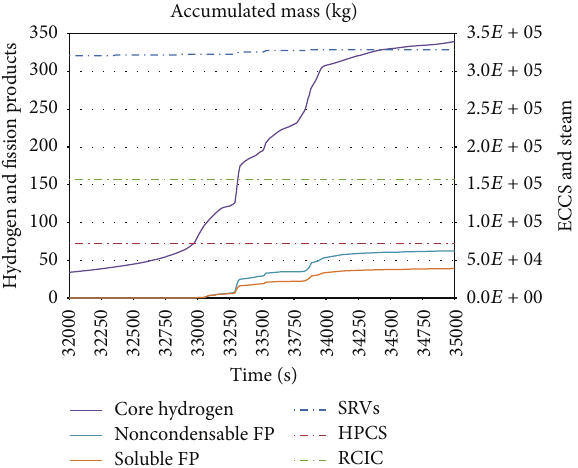
Figure 15: Maximum temperatures at any node on the COUPLE mesh of debris bed and RPV wall.